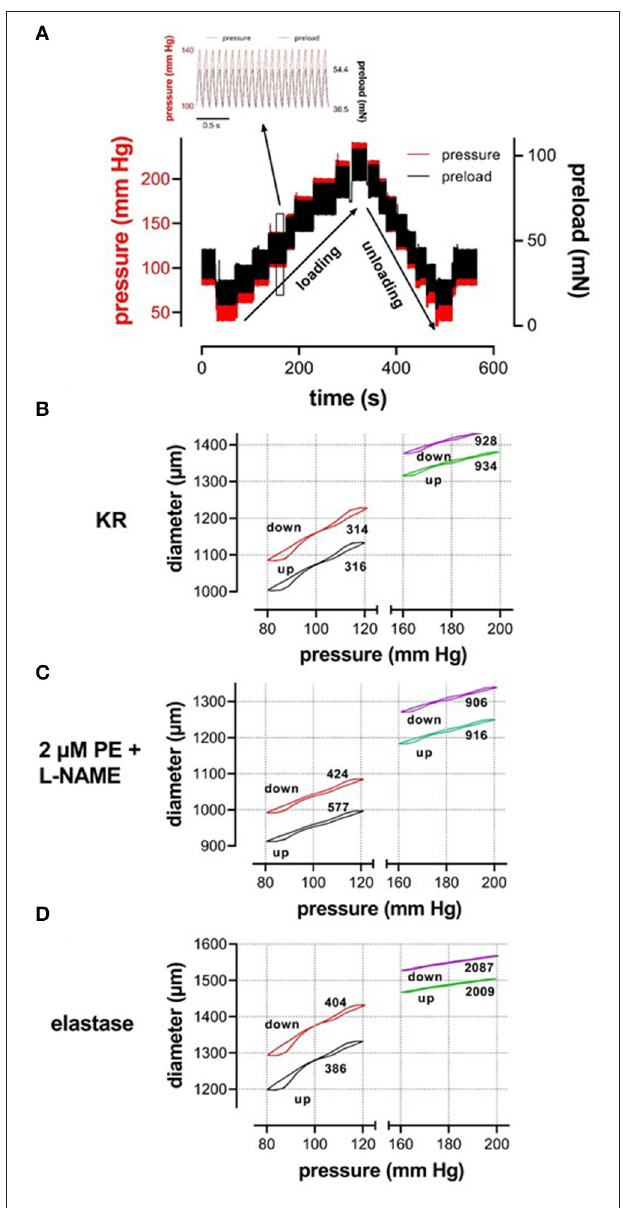
FIGURE 2 | (A) Test protocol applied to ROTSAC 1 to measure diameter, compliance, and Peterson modulus, E p . Starting at diastolic and systolic preloads, according to 80 and 120mm Hg, the preloads were adapted to obtain diastolic and systolic pressures of 40 and 80mm Hg and subsequently increased by 20mm Hg up to 200–240mm Hg or higher (loading). Thereafter, the pressure was decreased back to 40–80mm Hg (unloading) and, finally, to 80–120mm Hg. In the insert, preload and calculated pressure are shown during the clamp of the segment at 10Hz between 100mm Hg (36.5 mN) and 140mm Hg (54.4 mN). Similar protocols were applied to ROTSAC 2, 3, and 4 with the same pressure steps but other preloads. (B–D) Illustrate stretch-by-stretch diameter-pressure loops at 80–120 (black, red) and 160–200 (green, purple) during loading (up, black, green) and unloading (down, red, purple) in three experimental conditions: Krebs-Ringer (KR, B ), 2 µ M PE + 300- µ M L-NAME (C) , and 0.1 mg/ml elastase (D) . The left y-axis refers to diastolic and systolic diameters at 80–120mm Hg and the right axis to these parameters at 160–200mm Hg. The y-axis scale is the same in all figures. The numbers along each loop indicate the E p value in mm